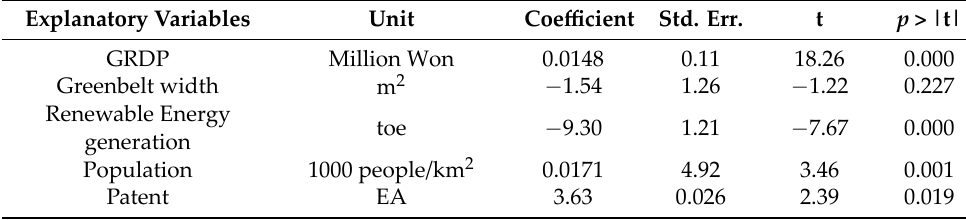
Table 5. Tobit regression result.